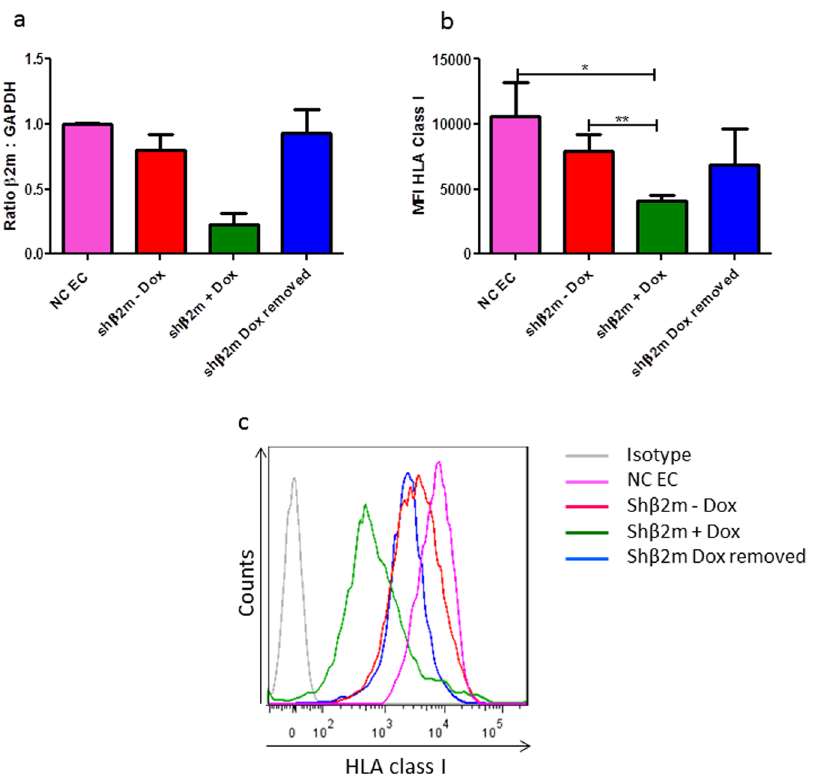
Figure 6. Regulation of endothelial HLA class I silencing by Doxycycline. ECs expressing sh β 2m and the trans-activator tTR-KRAB were cultured in the presence or absence of 100 ng/ml doxycycline and after removal of doxycycline. Levels of β 2-microglobulin transcripts ( a ) measured by real-time PCR were higher in non- modified ECs, transduced ECs in the absence of doxycycline (sh β 2m – Dox) or after withdrawal of doxycycline (sh β 2m Dox removed). ( b ) These results were confirmed at protein level as detected by flow cytometric analysis of HLA class I expression. The bar graphs represent mean values and standard deviations (n = 3). ( c ) Representative overlay of HLA class I expression in presence and absence of